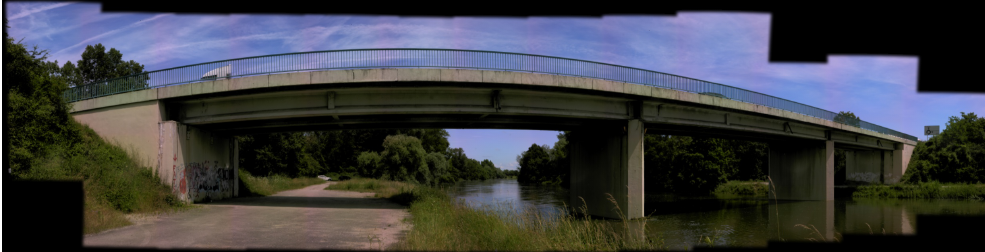
Figure 1. Example of a panoramic image captured with Trimble SX10 on a bridge using the primary camera and an overlap of 20% between individual pictures.